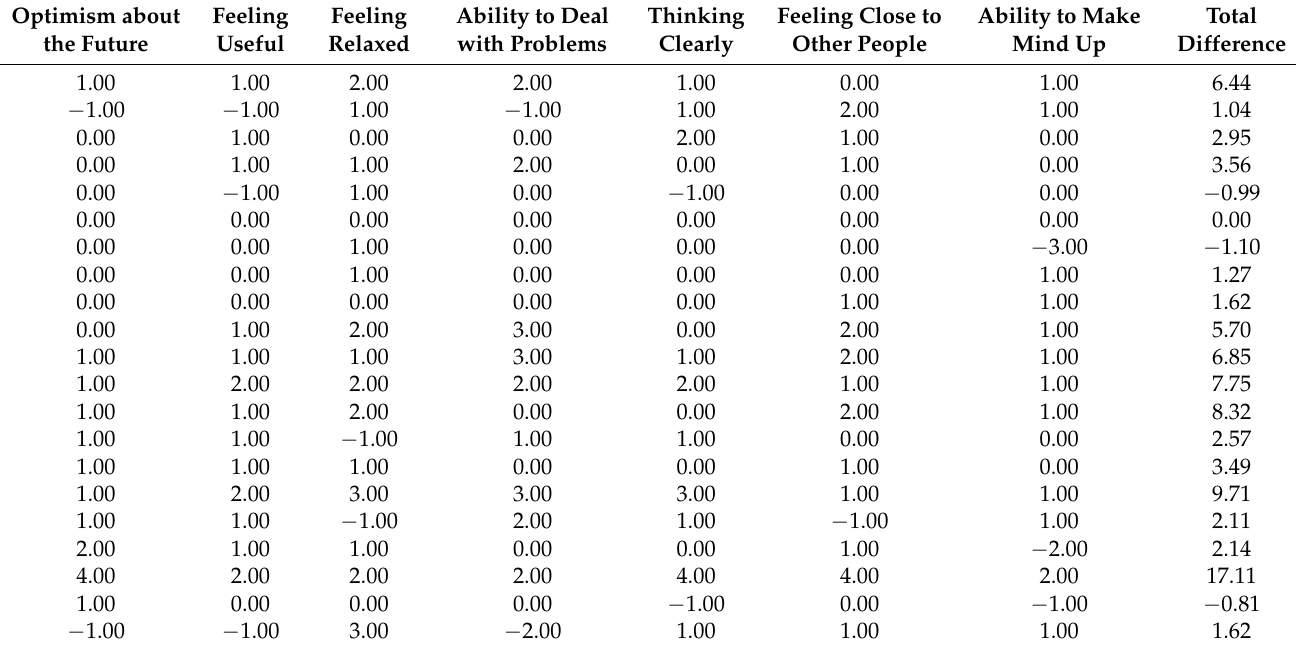
Table 3. Differences between scores on the Short Warwick-Edinburgh Mental Wellbeing Scale upon entry and exit to the